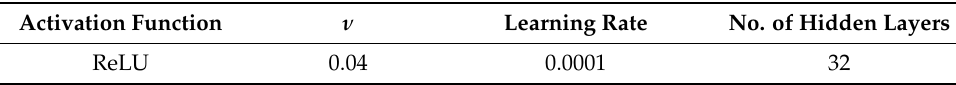
Table 3. Model hyperparameters for